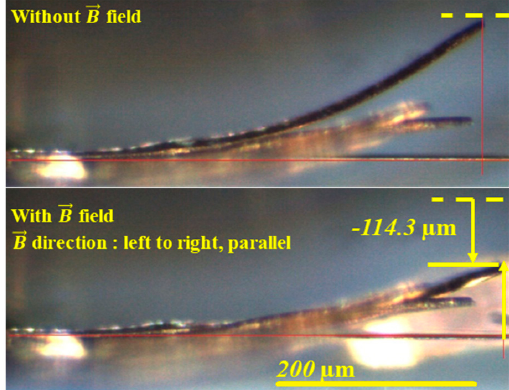
Figure 8. Optical images of side view for the typical magnetostrictive actuation of the Si- Tb 0.34 Dy 0.65 Fe 1.9 bi-material cantilever for the cases without magnetic field and with a magnetic field of 11 kOe along the cantilever direction.